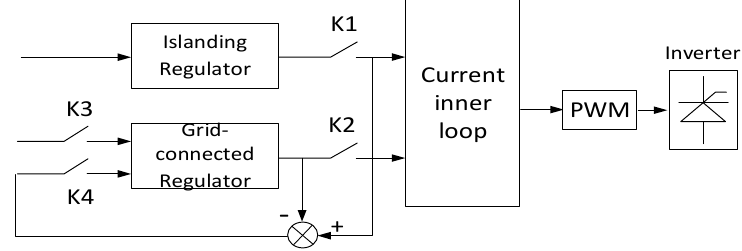
Figure 7. Scheme of regulation state follower from islanding mode to grid-connected mode.